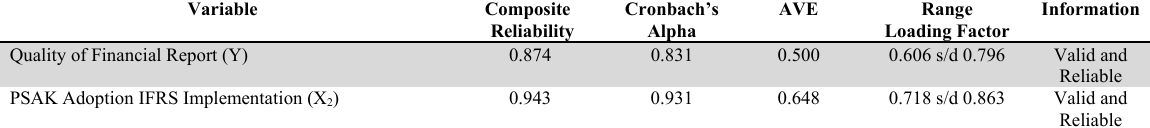
Test results for variables with reflected indicators in terms of validity and reliability Variable